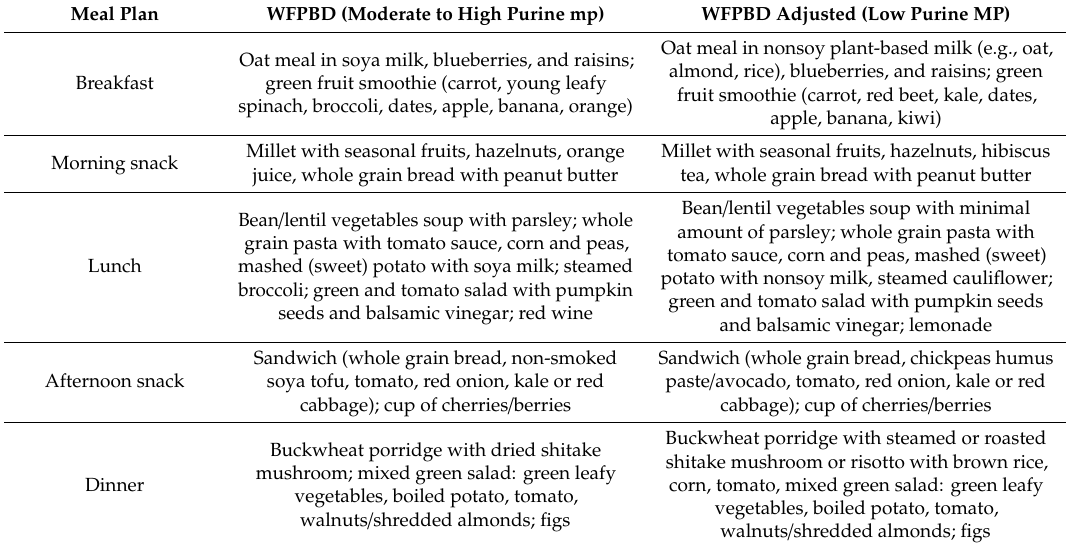
Table 3. Modification of a whole food plant-based diet (WFPBD) meal plan to lower purine